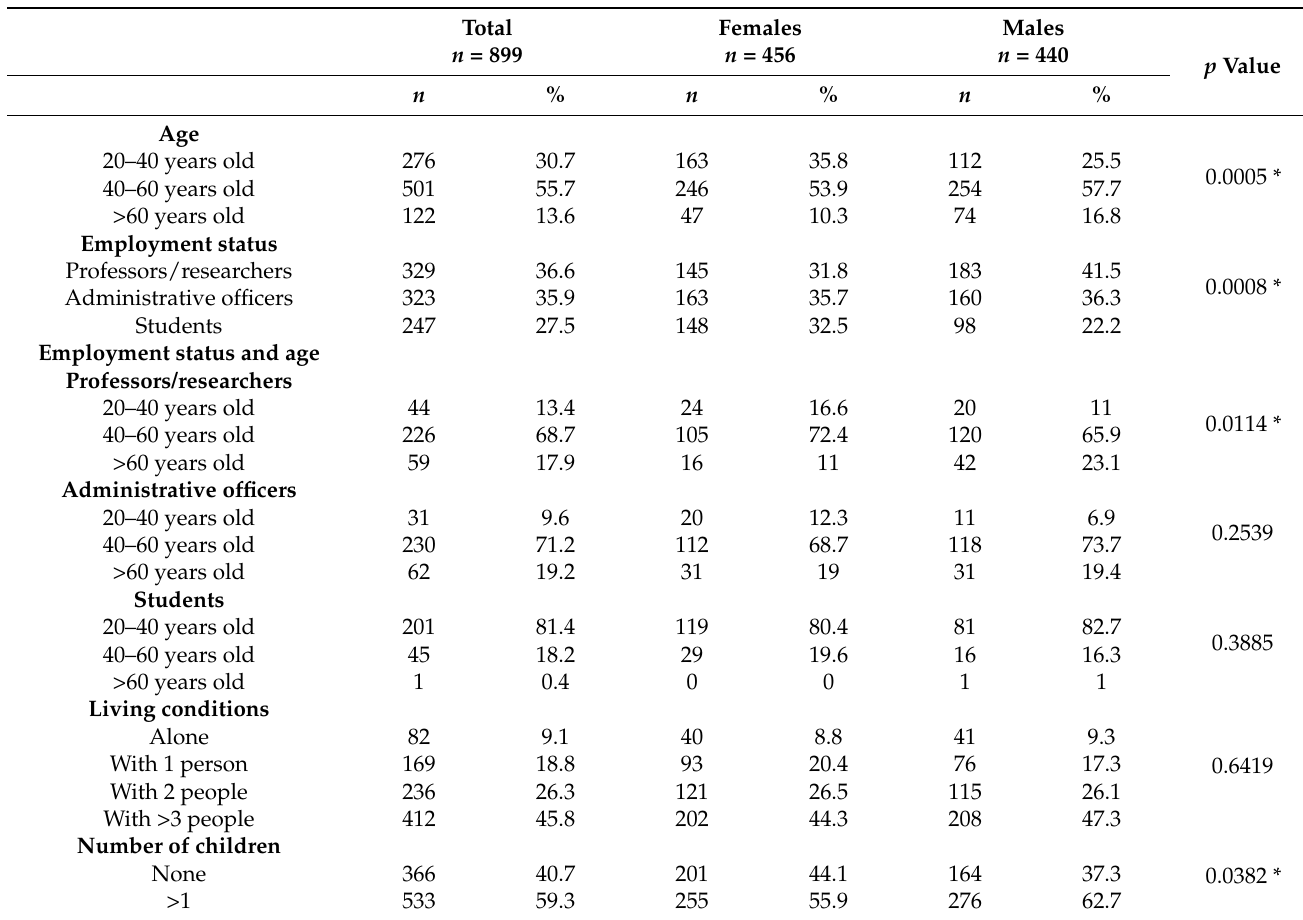
Table 1. Socio-demographic characteristics ( n =